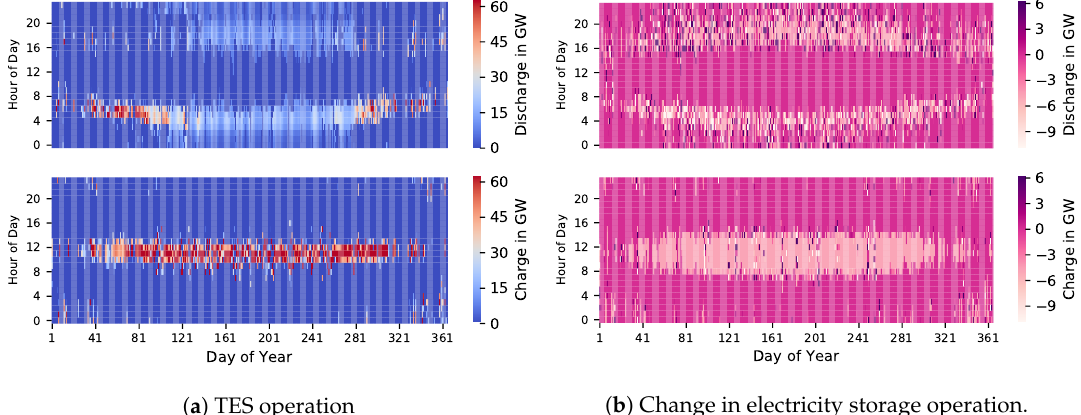
( b ) Change in electricity storage operation. Figure 6. Temporal operation of TES during the year ( a ) and caused differences in storage charge and discharge for lithium storage units ( b ) due to heat pump operation with and without